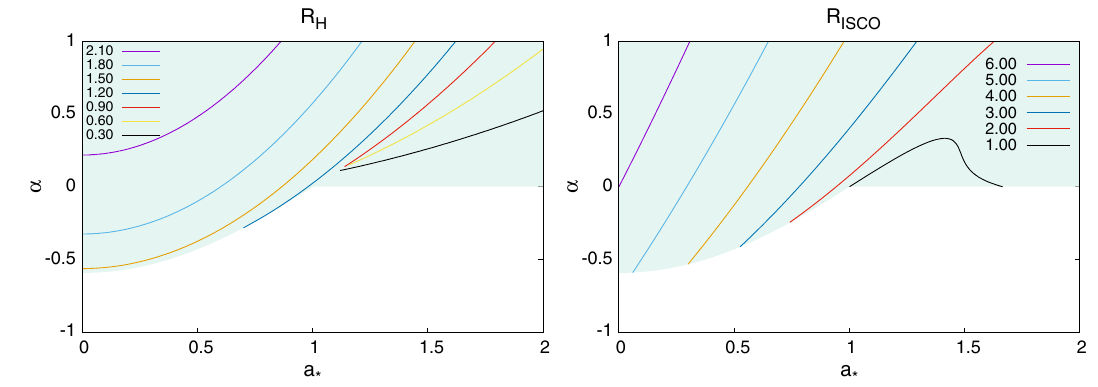
Fig. 1 Contour levels of the radial coordinates of the event horizon R H (left panel) and of the ISCO R ISCO (right panel) in the plane a ∗ vs α in units M = 1. The parameter space in white is ignored in our study because the spacetimes there have no black holes but naked